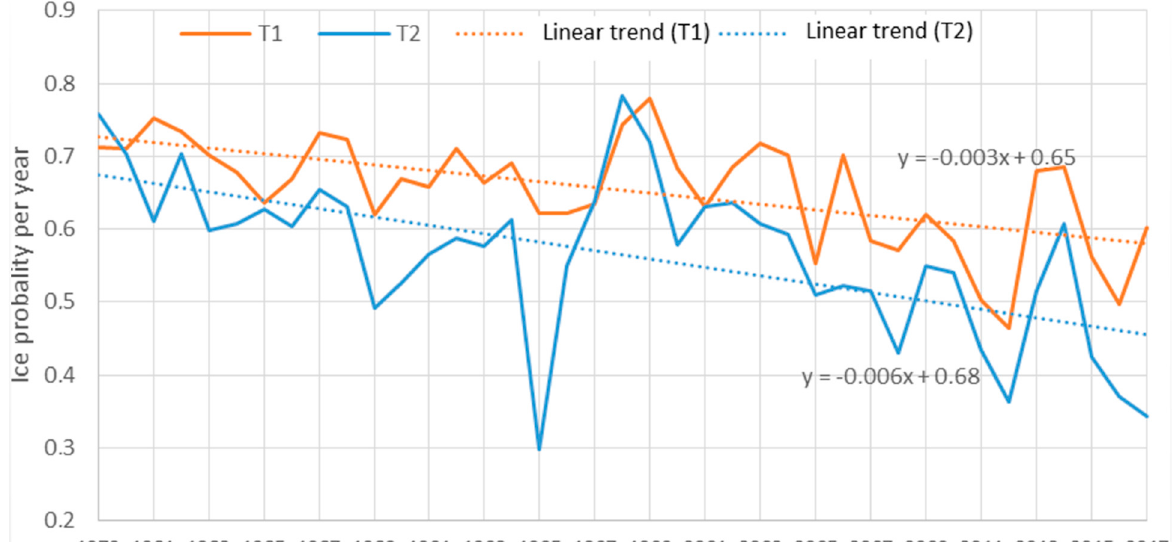
Figure 11. The probability of the ice presence with a concentration of more than 50% for two points in the Kara Sea by